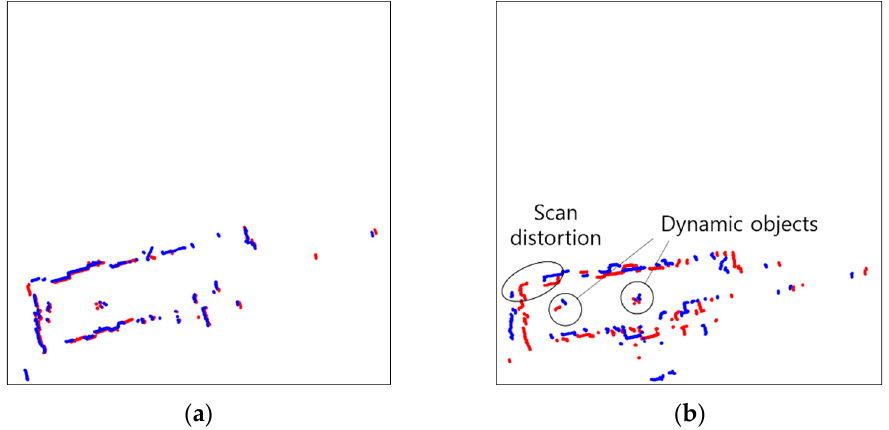
Figure 13. Scan matching images in environment 1 (Red: Previous scan, blue: current scan). ( a ) Normal matching images; ( b ) faulty matching images.